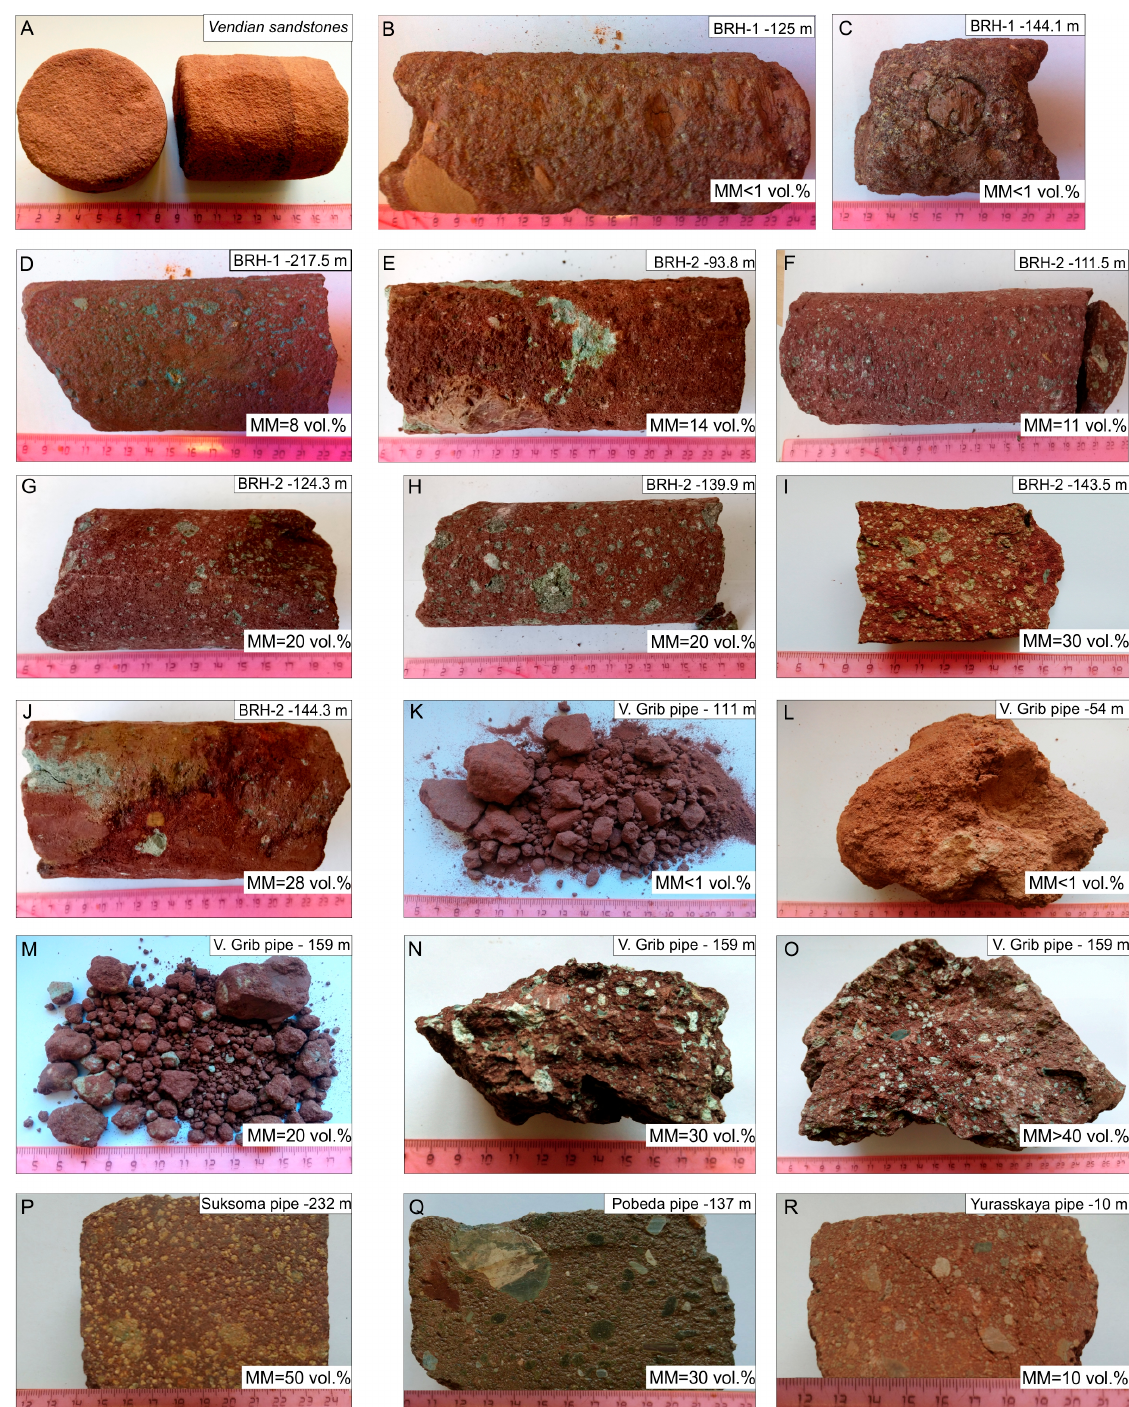
Figure 4. Photographs of the representative studied samples. ( A ) Vendian sandstone; ( B – J ) KL-01 pipe; ( B – D ) from borehole-1 (BRH-1), ( E – J ) from borehole-2 (BRH-2); ( K – Q ) sandstones from the crater part of the V. Grib kimberlite pipe; ( P ) sandstone from the crater of the Suksoma olivine melilitite/picrite pipe; ( Q – R ) sandstones from the crater parts of Pobeda ( Q ) and Yurasskaya ( R ) kimberlite pipes. Depth of sampling is marked from the surface. Schematic sections of the magmatic pipes are shown on Figure S2.